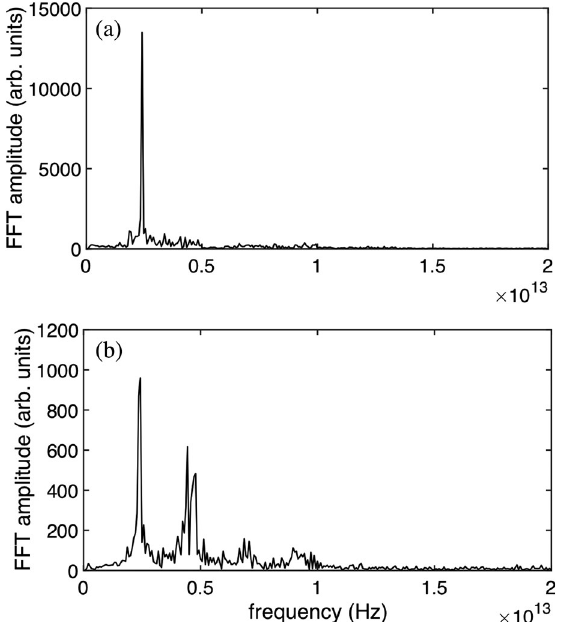
11. FFT spectra for the corresponding bunch histograms at s ¼ 93 m and 97 m, i.e., Fig. 10(b) and (c), respectively. The initial density modulation is assumed 125 μ m, which corresponds to 2.4 THz. It is evident that the higher harmonics emerge in the bottom